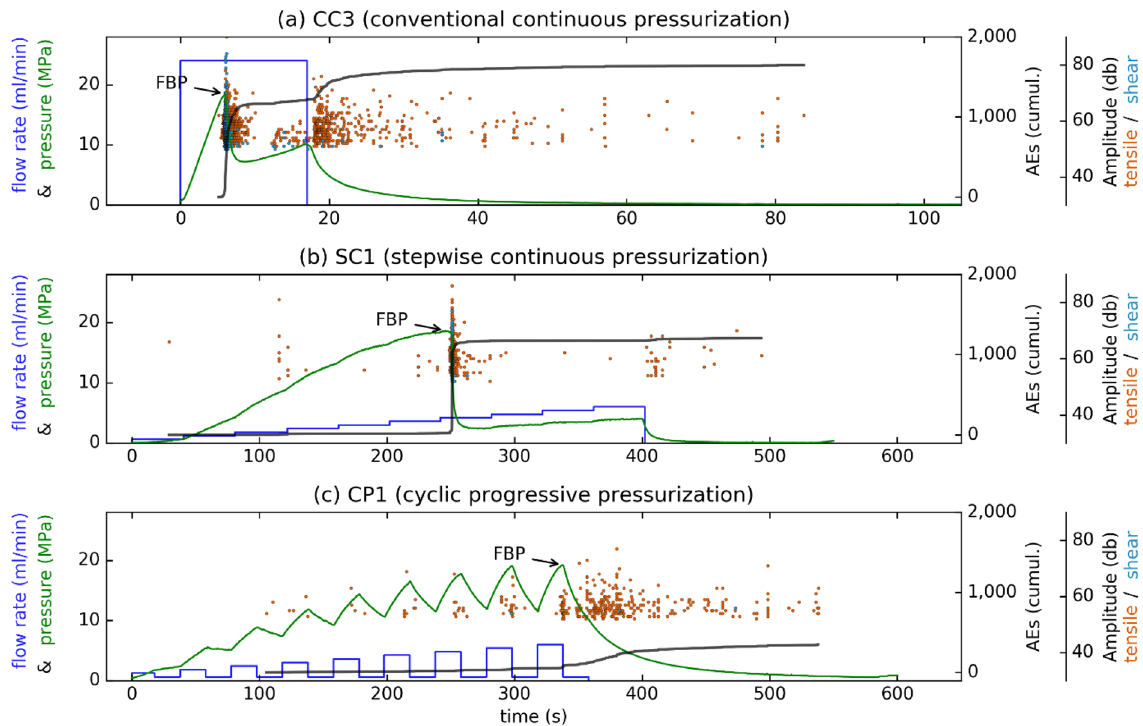
Figure 3. Laboratory hydraulic-fracturing results on true triaxially stressed Pocheon granite cubes with three fluid-injection schemes. Flow-rate-control tests with ( a ) conventional- continuous, ( b ) stepwise-continuous, and ( c ) cyclic-progressive pressurisation. Red dots indicate induced AE tensile failure; light-blue dots indicate induced AE shear failure. Other parameters were chosen to be analogous to those in Fig.